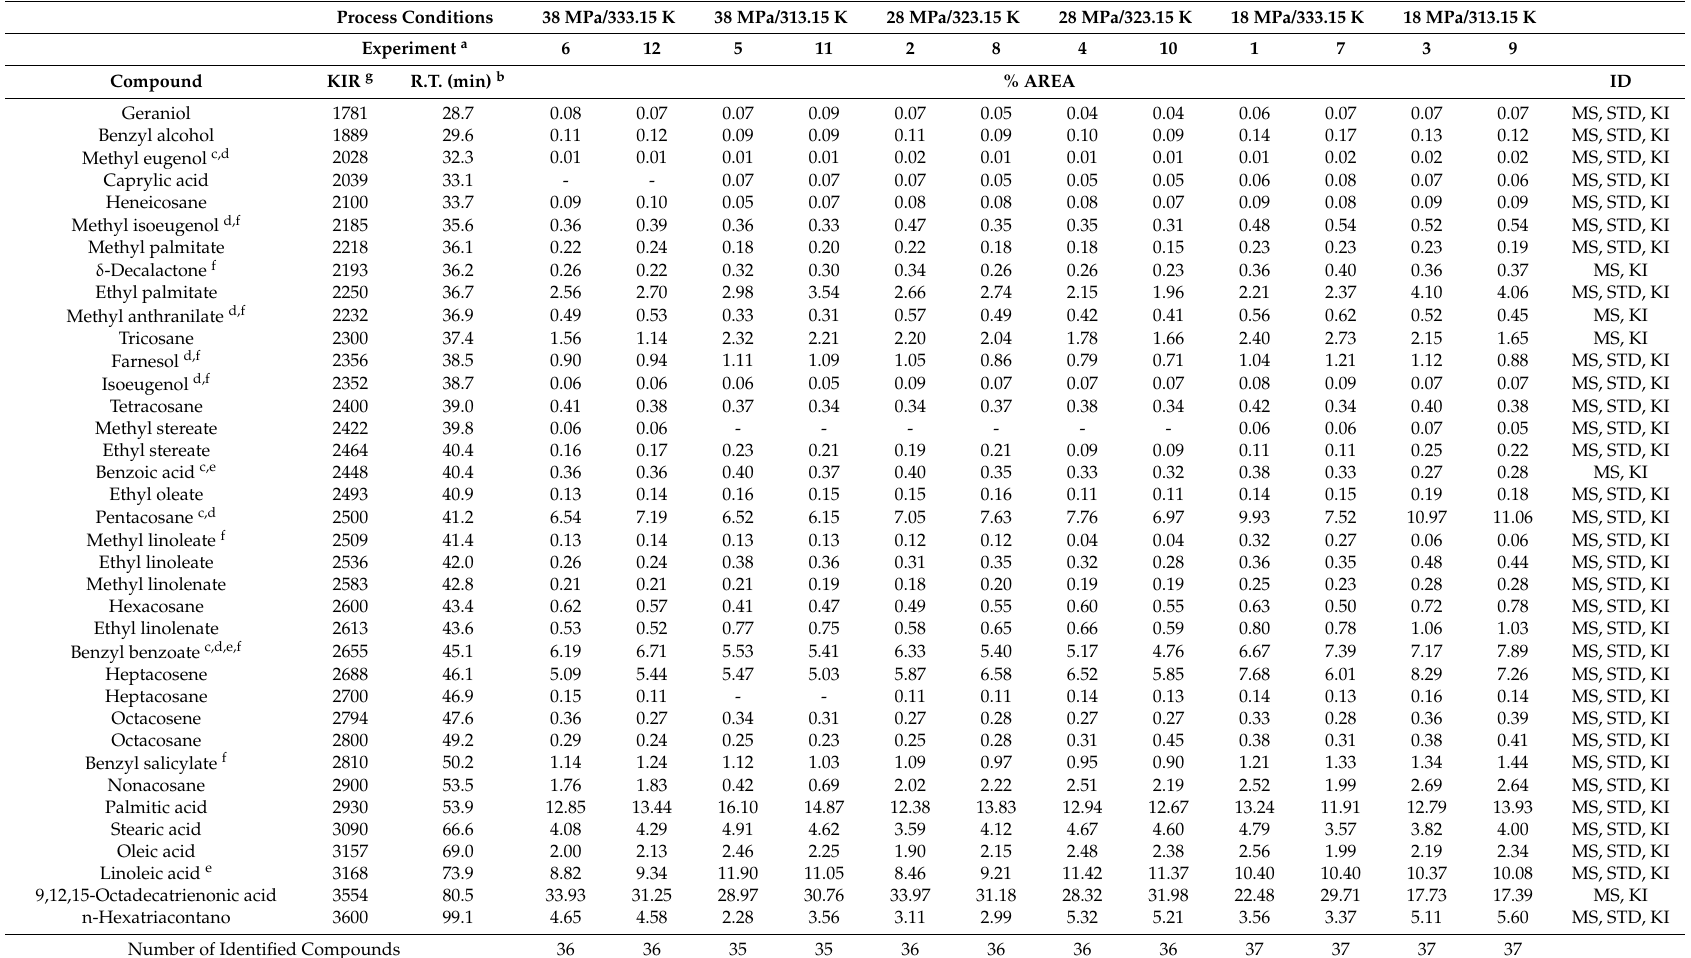
a Experiment: Number of experiments in experimental design. b R.T.: Retention time. Compounds reported in Polianthes tuberosa : c Gosh et al. [4], d Reverchon et al. [20], e Bin et al. [14],